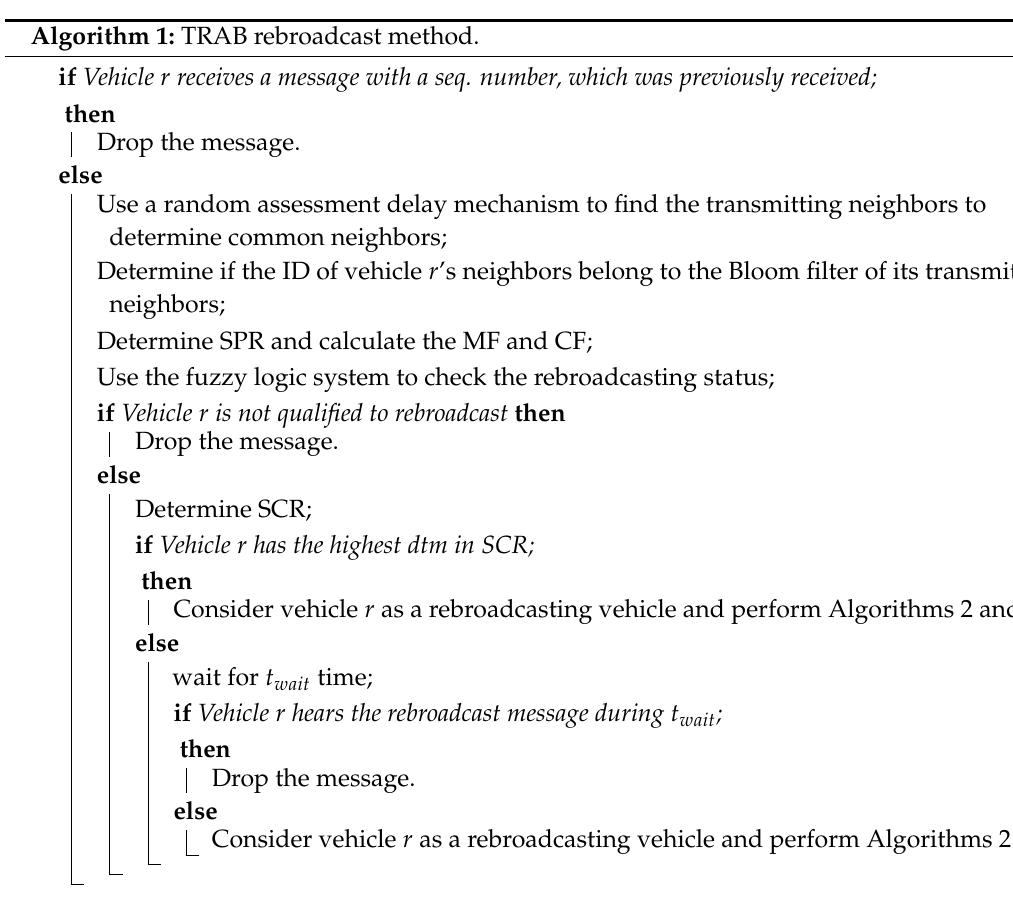
Algorithm 1: TRAB rebroadcast